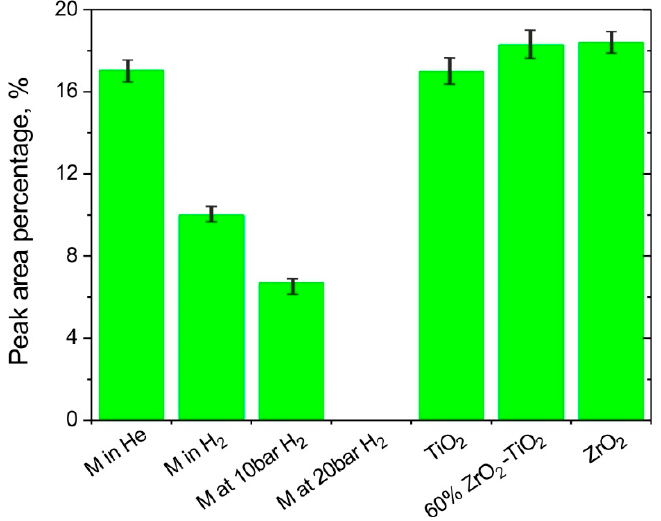
Figure 4. The peak area percentages for HAc.